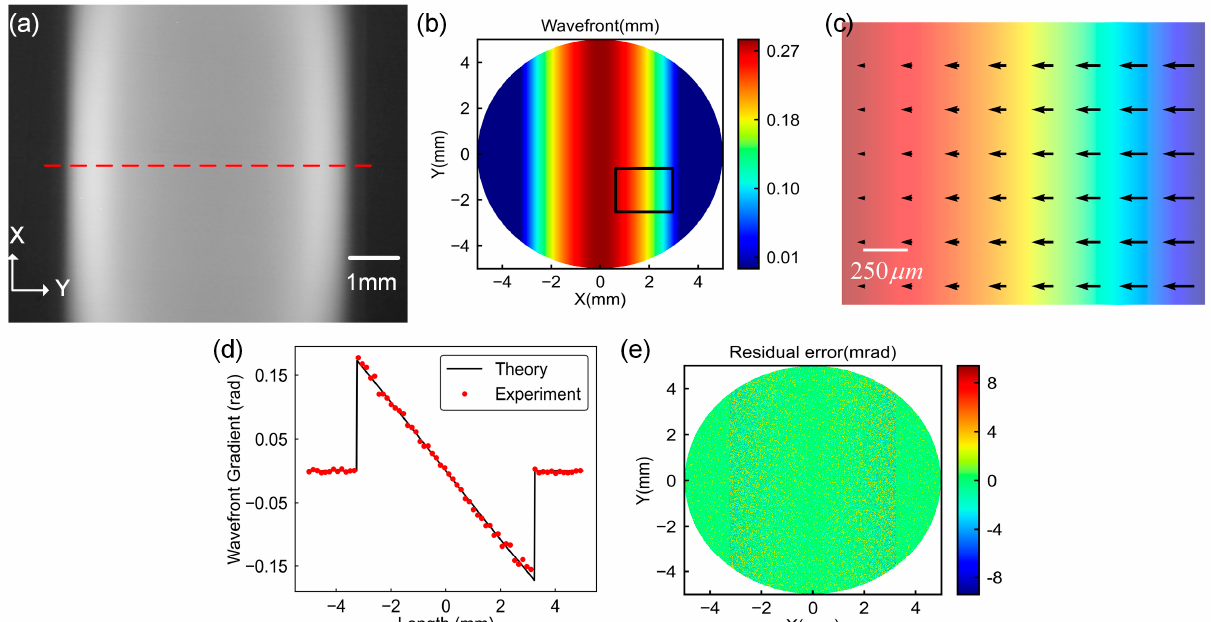
Figure 3. Characterization of the wavefront sensor. ( a ) Intensity image captured by the wavefront sensor. ( b ) Wavefront of the plano-convex cylindrical lens reconstructed using Zernike polynomials. ( c ) Enlarged image of the content in the black rectangle of Figure 3. The arrows represent the gradient information of the wavefront. ( d ) Profiles of the wavefront gradients along the center of the intensity image. The red circles represent the experimentally measured gradients and the solid black line represents the theoretical values. ( e ) Residual error map for measured wavefront gradients.